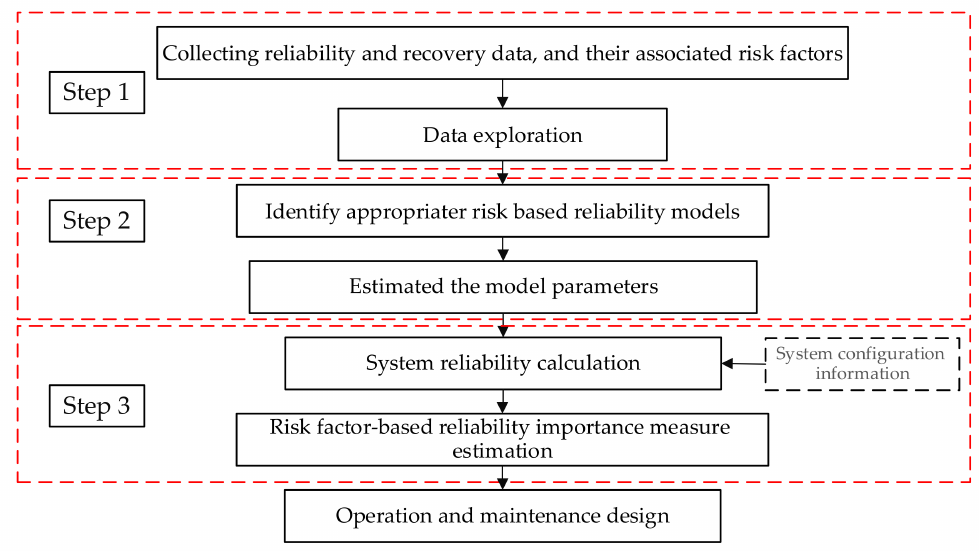
Figure 2. The framework proposed for risk factor-based reliability importance measure